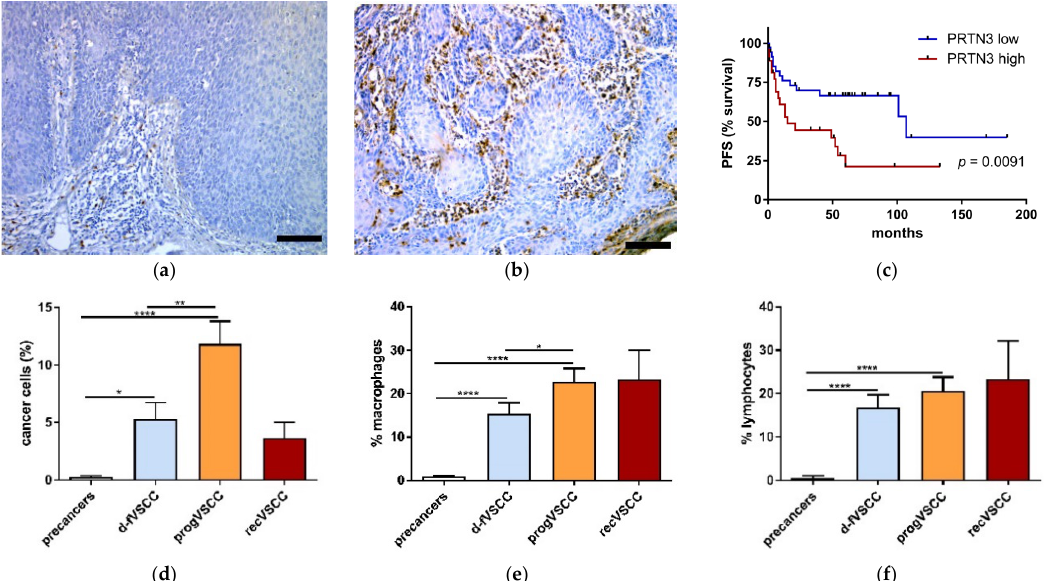
Figure 3. The results of PRTN3 immunostaining. Examples of immunohistochemical PRTN3 staining performed on tissue sections of HSIL ( a ) and VSCC tumors ( b ). Images were taken at 20x ( a-b ). Scale bar, 100 μm. The percent of PRTN3-positive neoplastic cells ( d ), macrophages ( e ), and lymphocytes ( f ) in vulvar pre-cancers (HSIL; n = 40 and dVIN; n = 5), d-fVSCC ( n = 34), progVSCC ( n = 31) and recurrent VSCC ( n = 3) samples. Survival curve (time to progression) according to the proportion of PRTN3-positive cancer cells ( c ) in primary VSCC tumors ( n = 64). Significant alternations are indicated by asterisks (*, p - value ≤ 0.05; **, p - value ≤ 0.01; ***, p - value ≤ 0.001; ****, p - value ≤ 0.0001). Abbreviations: PFS, progression-free survival; high and low, high and low proportions of PRTN3-positive cells.